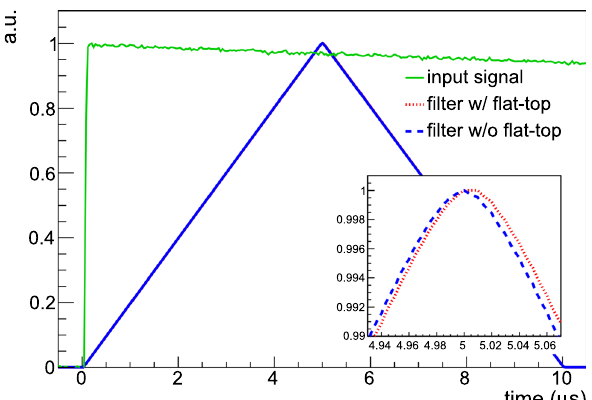
Fig. 2 Two examples of optimum WFs, i.e., the convolution of the simulated, exponentially decaying DPLMS filter input signal (green, τ = 150 μ s) and the two DPLMS FIR filters (not shown), synthesized inthecaseofsimulatedseriesnoise.AtriangularWF(blue)isgenerated withoutspecifyinganyflat-topconstraint,whileaminimallyflat-topped WF (one ADC sampling interval long, i.e., 10 ns, red) results instead from the procedure mentioned in the text